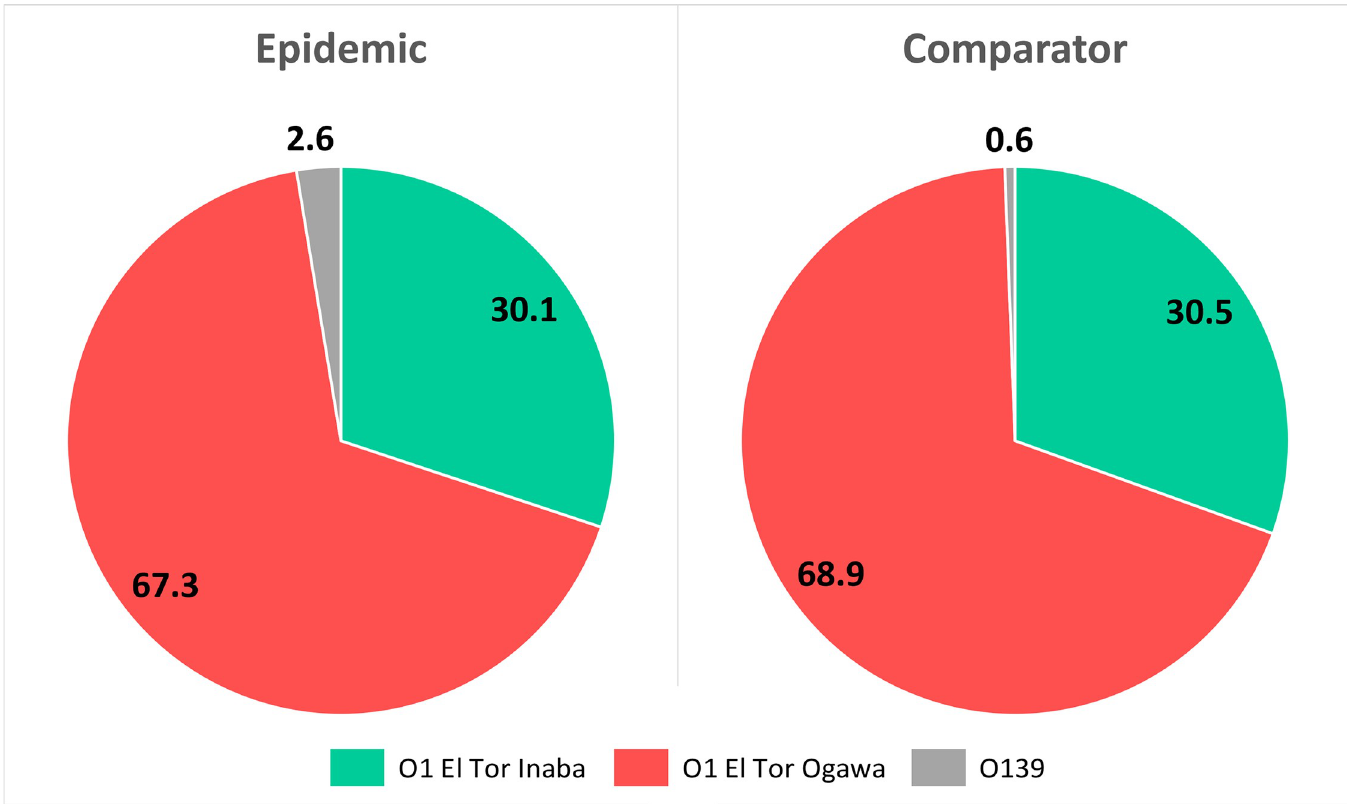
Fig 3. Percent distribution of types of Vibrio cholerae isolated from the cases (during the epidemic) and the controls (during the comparison period). No significant difference was found (P = 0.432) in the distribution of Vibrio cholerae types between the two groups on Fisher’s exact test.